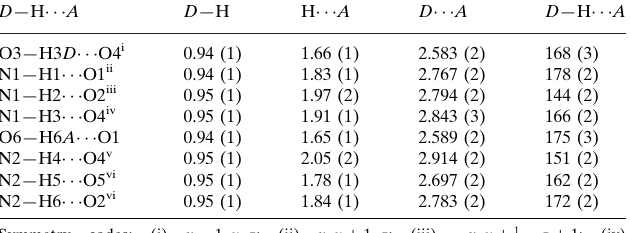
Hydrogen-bond geometry (A˚ , (cid:4)